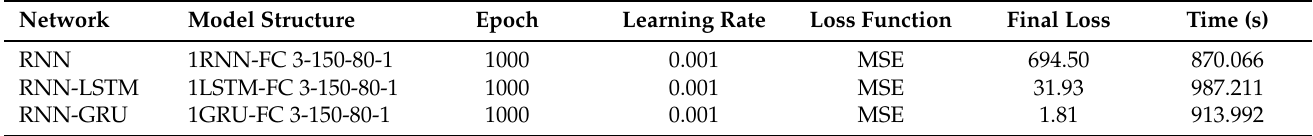
Table 1. State of Charge (SOC) estimation network structures for single discharge process.